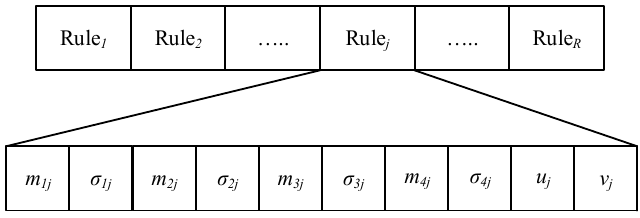
Figure 4. The FLC coding in the IDS.